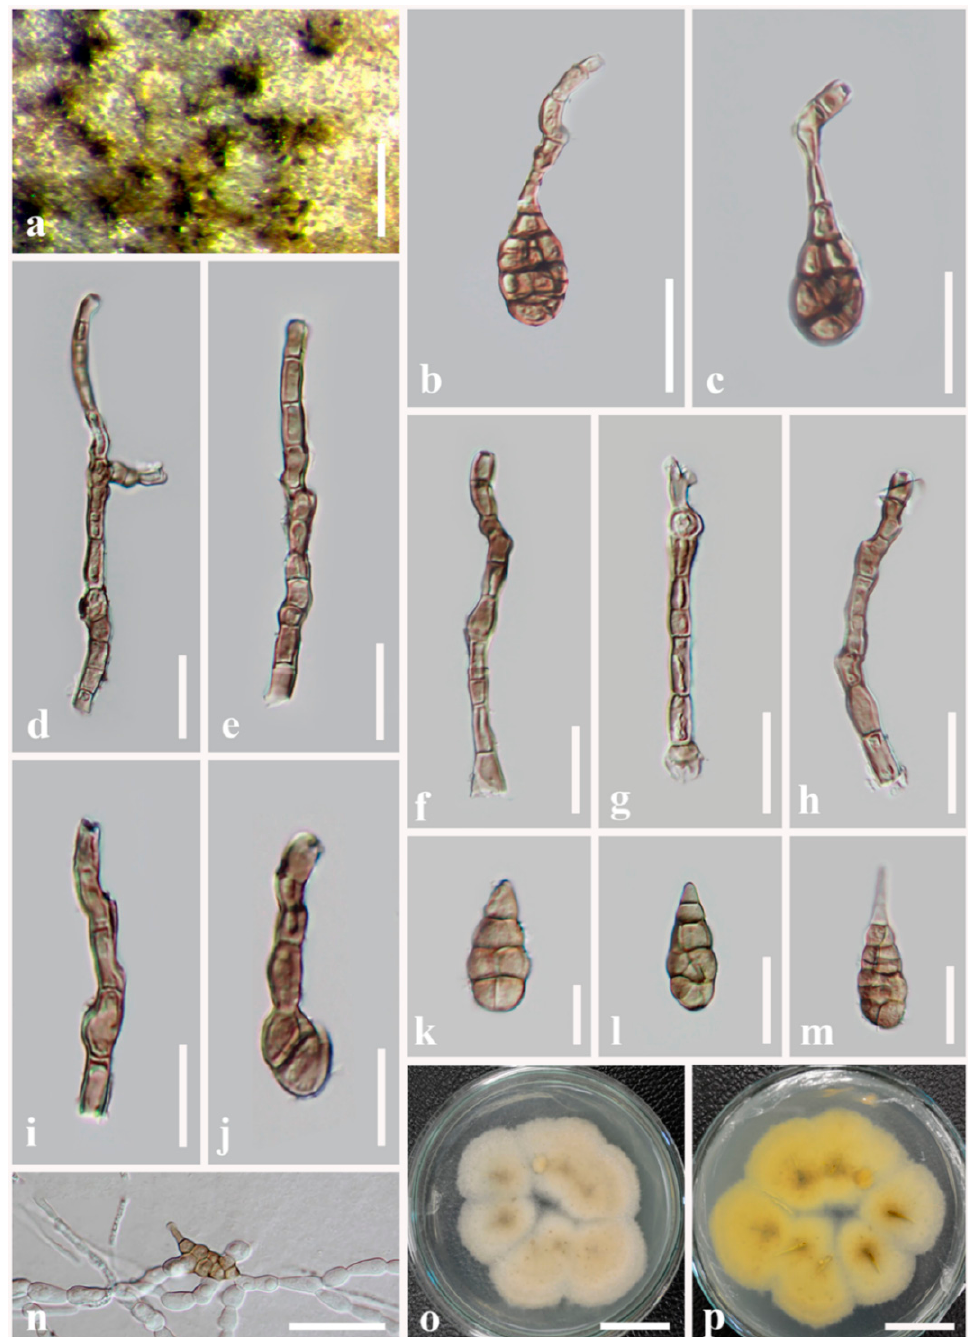
Figure 5. Alternaria pseudoinfectoria (MFLU 21-0311, holotype). ( a ) Colonies on dead stem of Chenopodium sp.; ( b , c , j ) Conidia formed apical secondary conidiophores; ( d – i ) Conidiophores; ( k – m ) Conidia; ( n ) Germinated conidium; ( o , p ) Colonies on PDA. Scale bars: ( o , p ) = 2 cm, ( a ) = 300 µm, ( b – f , h , n ) = 20 µm, ( g , i , j ) = 15 µm, ( k – m ) = 10 µm.